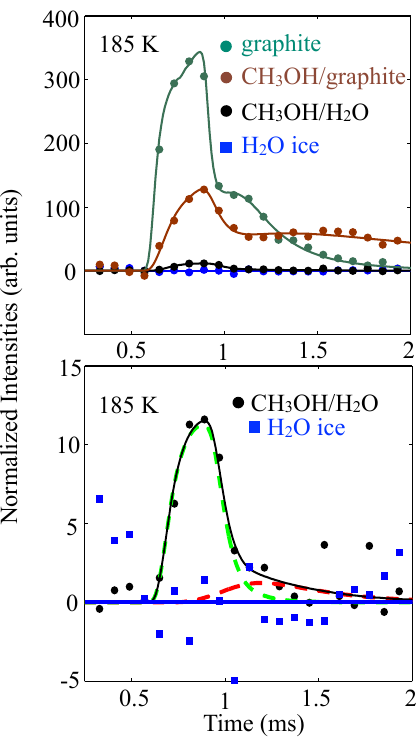
Fig. 2. Time-of-flight distributions for D 2 O scattering from differ- ent surfaces at 185K, normalized for variations in incident beam intensity and data collection time. In the upper panel the best non- linear fitting curves overlie the background corrected and eight- point averaged data. The lower panel is a zoomed-in-view of the curves for the bare (blue) and methanol coated (black) ice, where for the methanol coated case the complete non-linear fit is also de- composed into its inelastic scattering (dotted green curve) and ther- mal desorption (dotted red curve) components. No D 2 O desorption is observed from the pure ice.